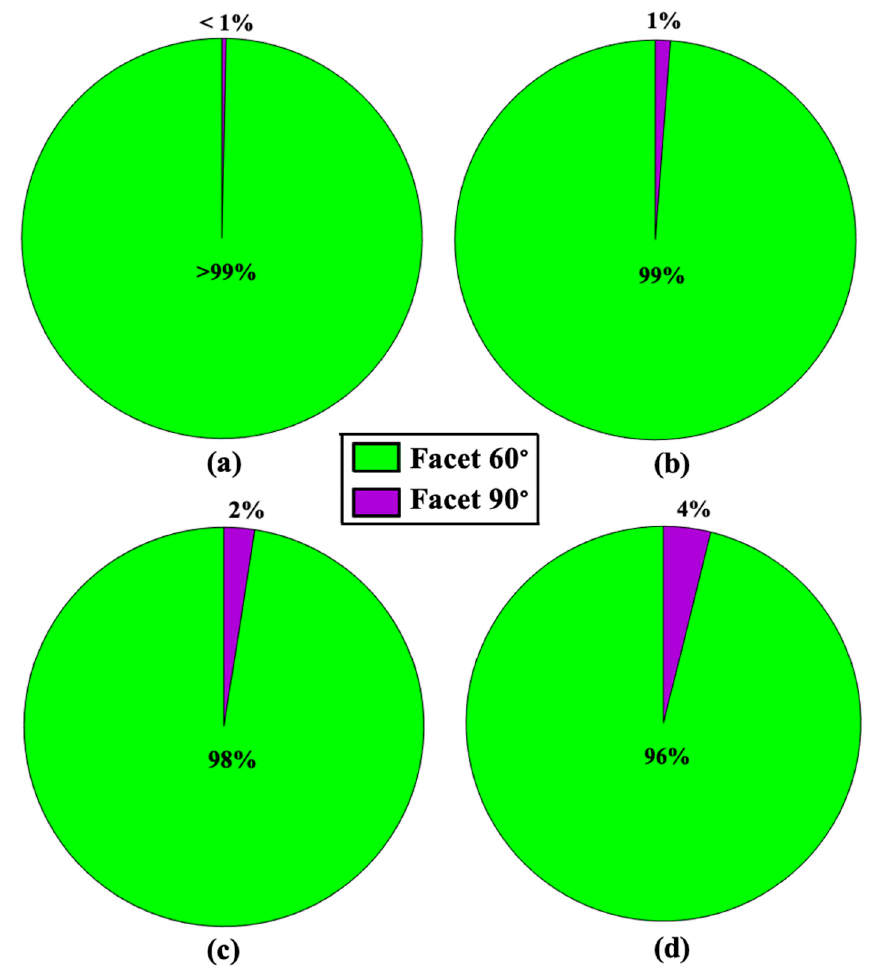
Figure 6. Contribution of each facet during sites dissolution of the whole crystal morphology of portlandite, after 5250 ( a ), 10,500 ( b ), 15,750 ( c ), and 17,461 ( d ) steps. Each step is representative of one site dissolution. Green and purple colors show the percentage of sites dissolution, which took place from 010 or 0 10 (facet 60°), and 110 or 1 10 (facet 90°) facets, respectively. The dissolution time of each individual site along 5250 (a), 10,500 (b), 15,750 (c), and 17,461 (d) steps were shown in Figure 7. It is clear that the majority of sites from both facets of 010 or 0 10 (green point), and 110 or 1 10 (purple cross) have been dissolved between 10 − 11 to 10 − 14 seconds as shown in (a–c). Those sites which have been dissolved for the time less than 10 − 14 second are concerning to the larger second random number selection which is close to 1 for dissolution time computation. However, the trend of random number selection is uniform, and it is impossible to avoid those larger random number selections close to 1.